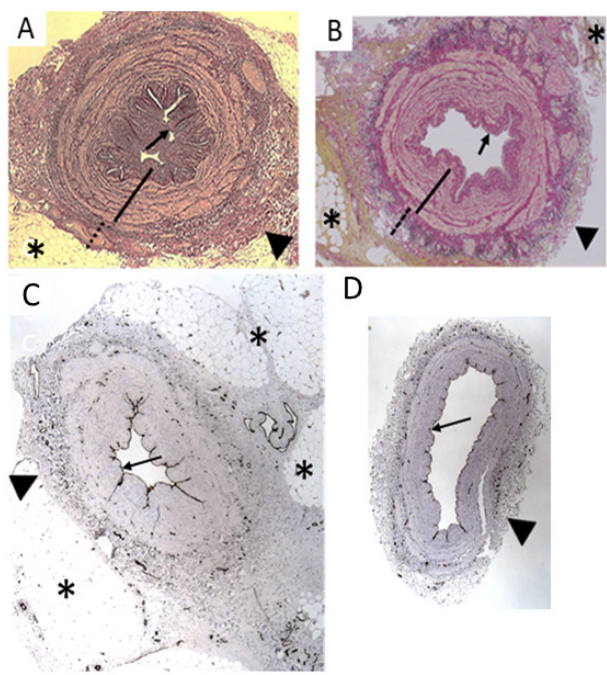
Fig. 3 - Histological appearance of saphenous vein grafts prepared using different techniques of harvesting. Top sections stained for muscle layers. A) Transverse section of a no-touch saphenous vein graft with perivascular adipose tissue. (From Dashwood et al. [9] , 2009). B) Transverse section of endoscopic no-touch saphenous vein graft with perivascular adipose tissue intact. (From Yoshino et al. [61] , 2020). C) No-touch saphenous vein with intact luminal endothelium, adventitia, and perivascular fat. (From Dashwood et al. [8] , 2013). D) Conventional saphenous vein with endothelium and adventitia damaged and perivascular adipose tissue removed. (From Dashwood et al. [8] , 2013). *=perivascular adipose tissue; arrowhead=adventitia; arrow=luminal